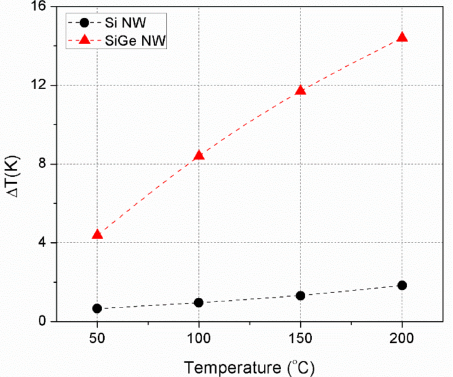
Figure 4. Estimated ∆ T across Si and SiGe NWs inferred from the Seebeck coefficients and the open circuit voltages measured for them as a function of the hotplate